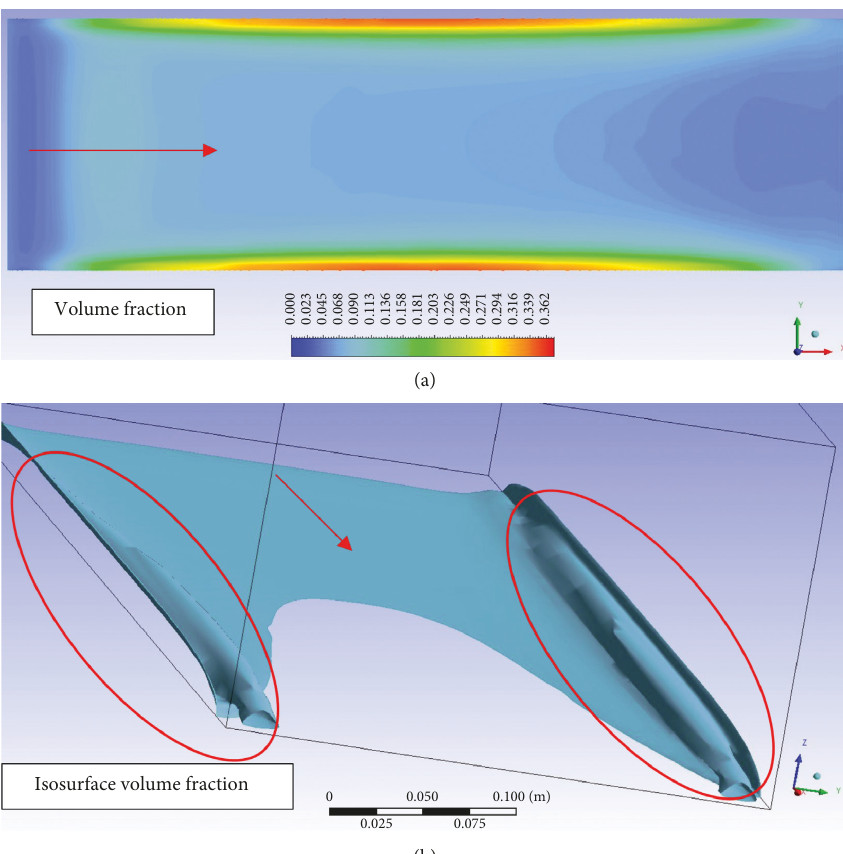
Figure 8: Particle settling bottom wall, the flow direction indicates by the arrow. Drill cutting size is 5mm and inlet volume fraction is 0.05. (a) The solid volume fraction of drill cuttings on the bottom of the open channel at steady state, xy plane. (b) Isosurface of solid volume fraction at